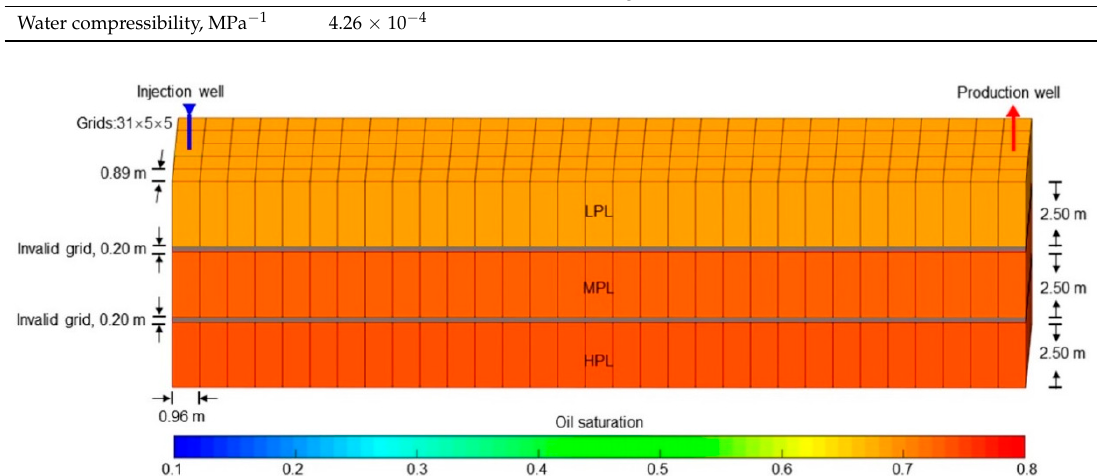
Figure 8. Grid system, well location, and 3D distributions of oil saturation in the initial state for the case without polymer degradation.